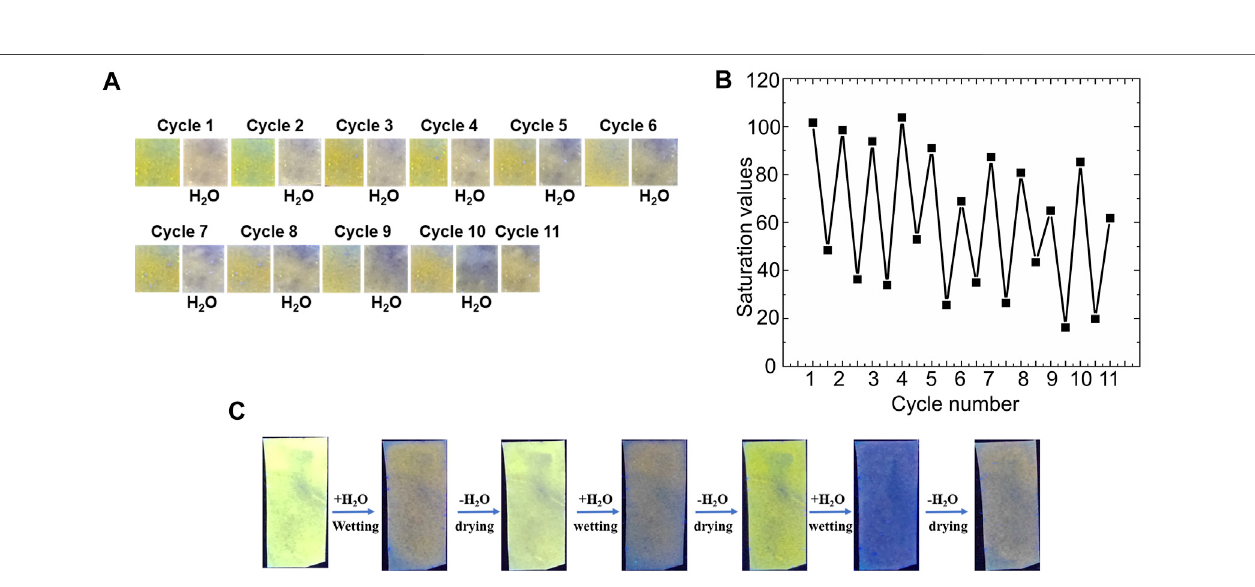
Frontiers in Chemistry |